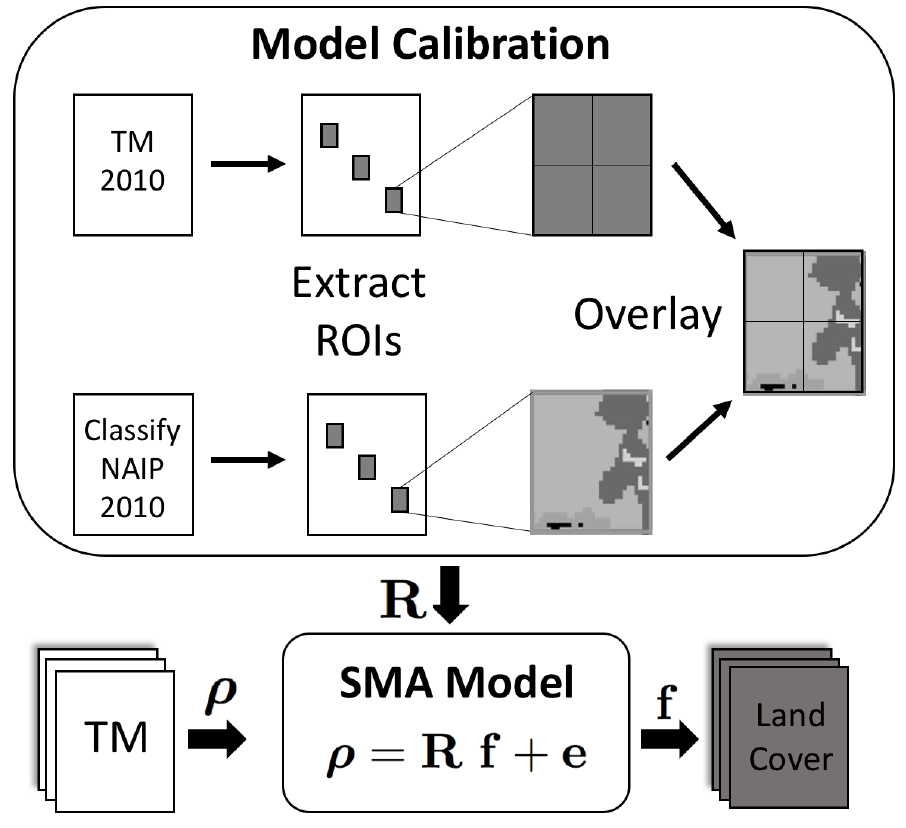
Figure 4. SMA modeling workflow showing the the step of computing calibration parameter R and estimating subpixel land cover fractions f from surface reflectance ρ .